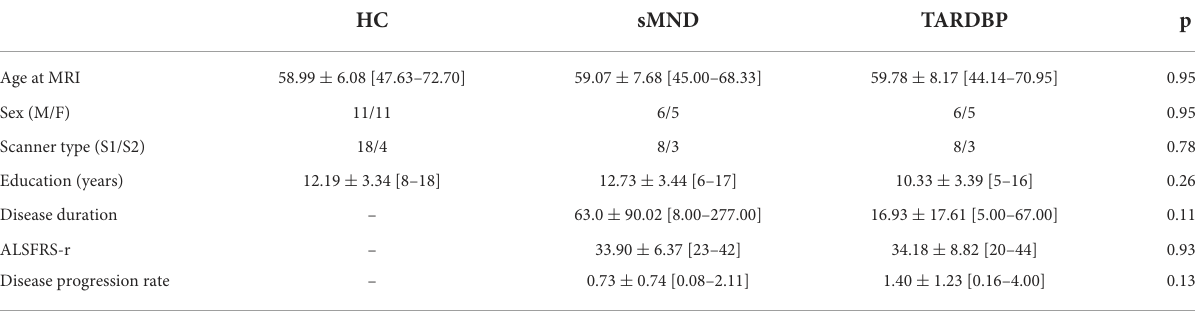
TABLE 1 Main clinical and demographic characteristics of subjects.